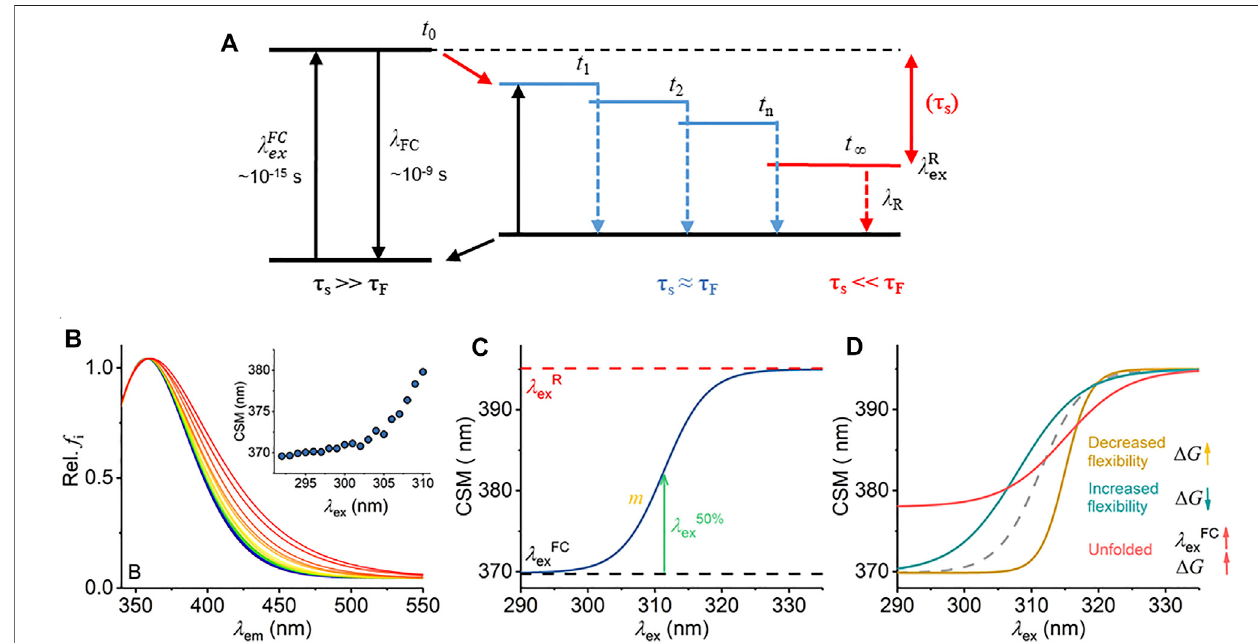
FIGURE 1 | Mechanism of the REES effect, predicted experimental observables, and graphical description of Eq. (7) . (A) Jablonski diagram illustrating the REES effect. (B) Example model Trp REES data showing the normalized emission spectrum with increasing excitation wavelength and inset as the change in CSM versus excitation wavelength. (C) Graphical depiction of Eq. (7) . (D) Predicted spectral changes resulting from variations in Eq. (7) from shifts in protein fl exibility and conformational state